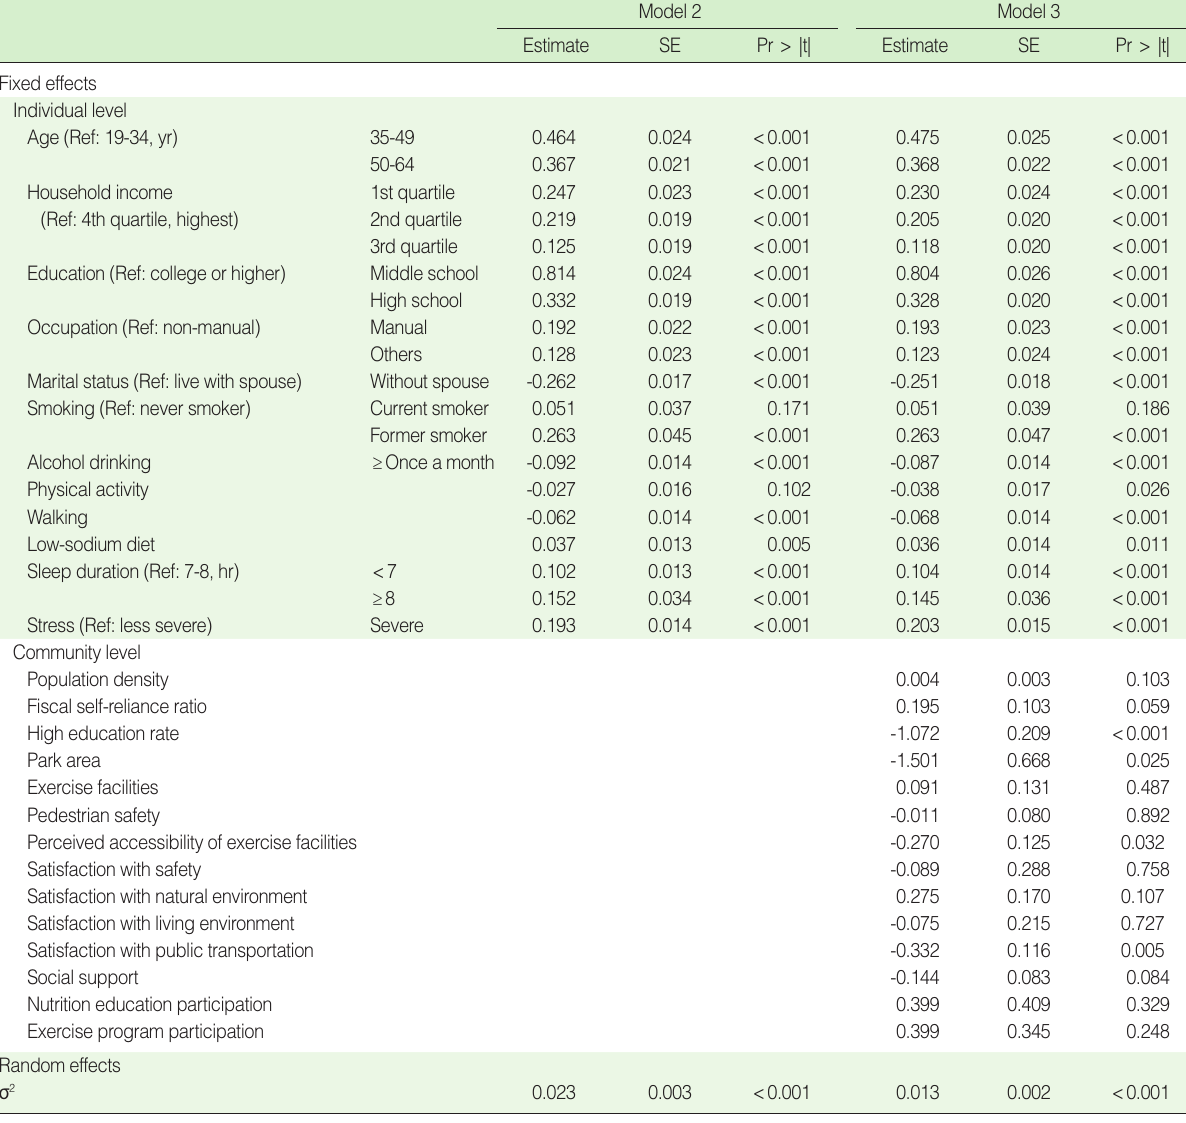
Table 4. Factors affecting obesity among women based on multilevel